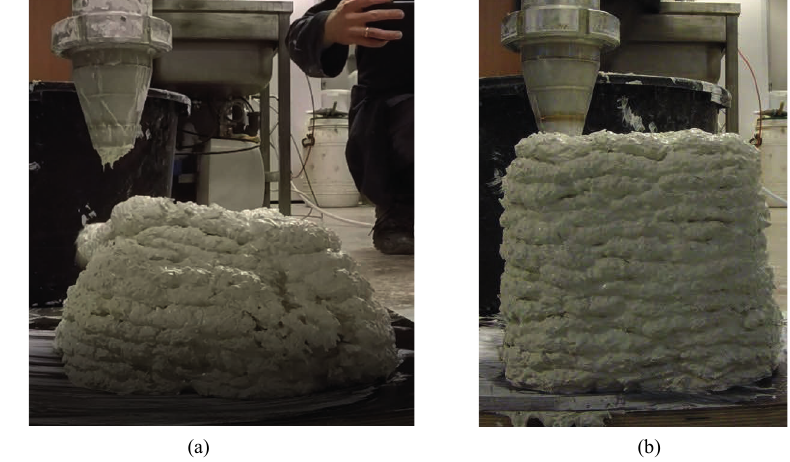
Fig. 4. Successful buildability test of a 15-layer sample with a height of 200 mm (a), collapse when printing higher layers without interruption (b). The printed layer together (lime+hemp+electricity) for both wall types produces 13.61 kg of CO 2 eq. regardless of the overall wall thickness because the thickness of the printed layer does not change. Most of the 120 mm thick layer emissions are caused by the lime binder of 23.7 kg of CO 2 eq. Lime binder for the inner part causes only 39 % of the emissions of the outer layer for Wall A and 73 % for Wall B. This shows that when applying 3D